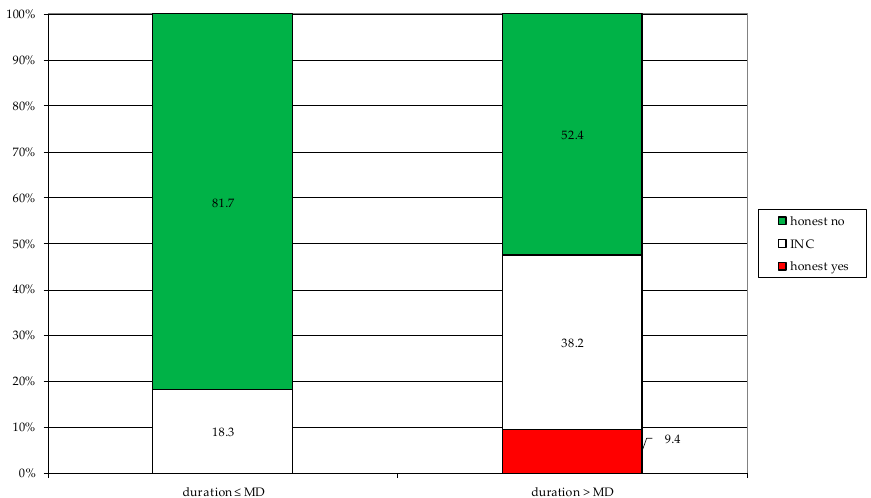
Figure 4. Prevalence of doping by relative time spent participating in a sport.